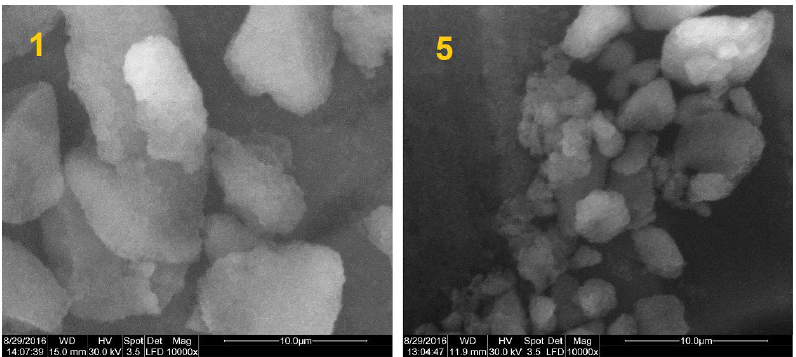
Figure 3. Environmental scanning electron microscopy (ESEM) images of dried pristine SiO 2